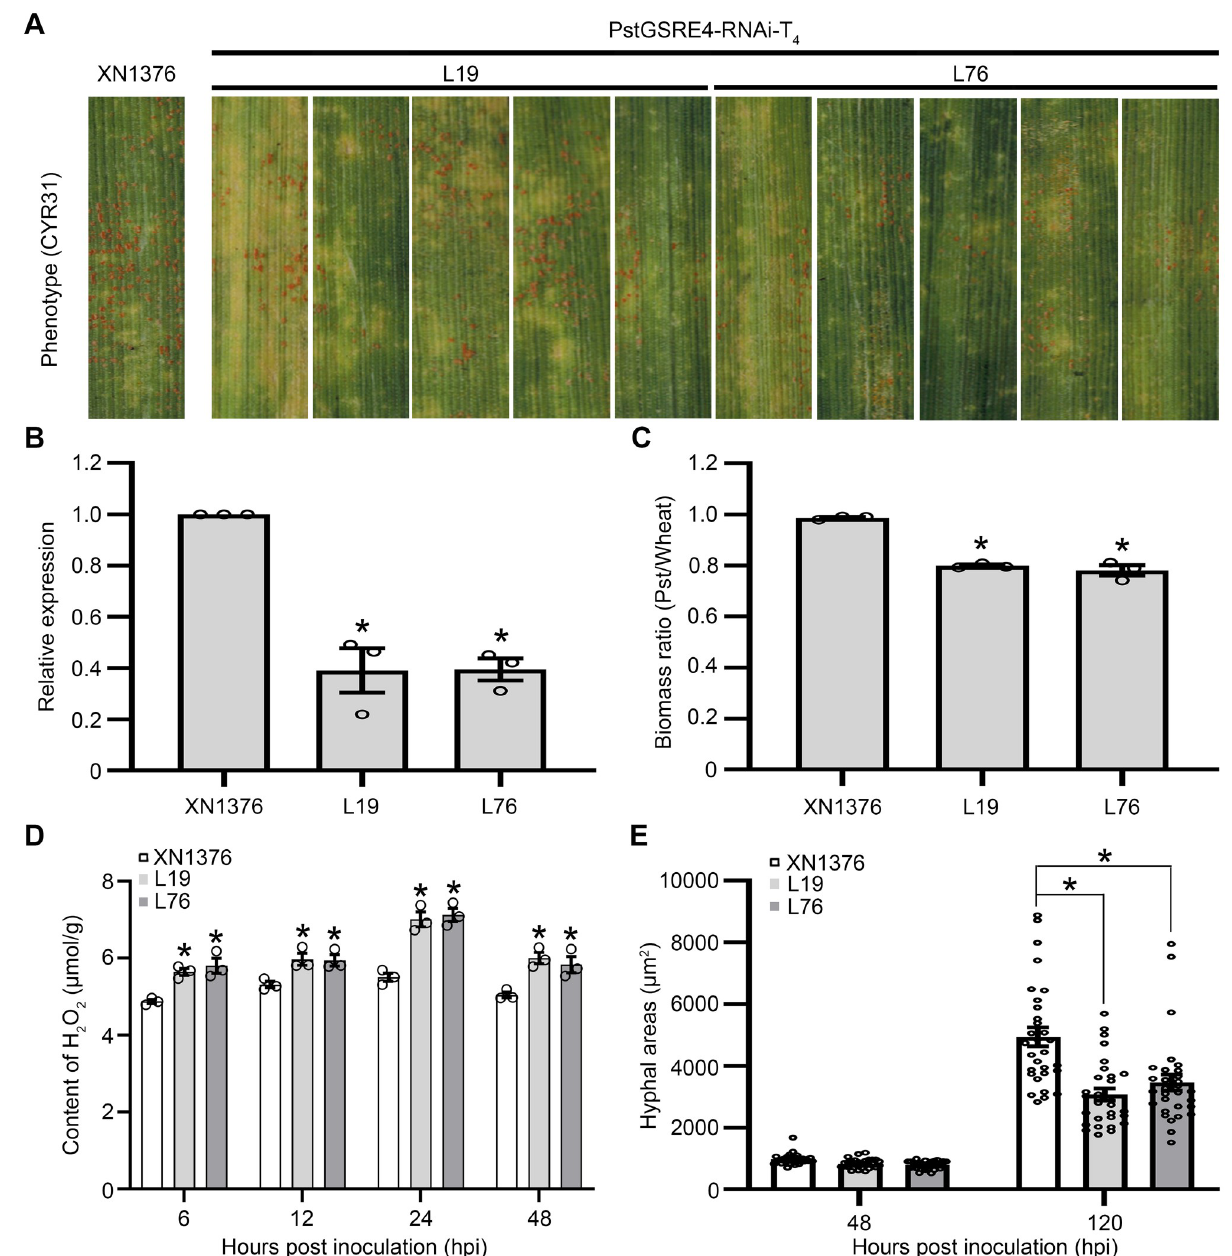
Fig 1. RNAi-mediated stable silencing of PstGSRE4 significantly reduces Virulence of Pst and increases H 2 O 2 accumulation in Wheat. (A) Phenotypes of the second leaves of the fourth generation of wheat plants at 14 dpi with Pst . (B) Relative transcript levels of PstGSRE4 in different transgenic lines at 48 hpi with Pst . Values represent the means ± SE (n = 3). (C) Ratio of fungal to wheat nuclear content using fungal PstEF-1 and wheat TaEF-1 α genes, respectively. Genomic DNA was extracted from the second leaf from three different plants at 14 dpi. Values represent the means ± SE (n = 3). (D) Content of H 2 O 2 in different transgenic lines at 6, 12, 24 and 48 hpi. Values represent the means ± SE of three independent samples. (E) Quantification of hyphal areas in different transgenic lines at 48 and 120 hpi. Values represent the means ± SE (n = 30). Differences were assessed using Student’s t -test. Asterisk indicates P < 0.05.